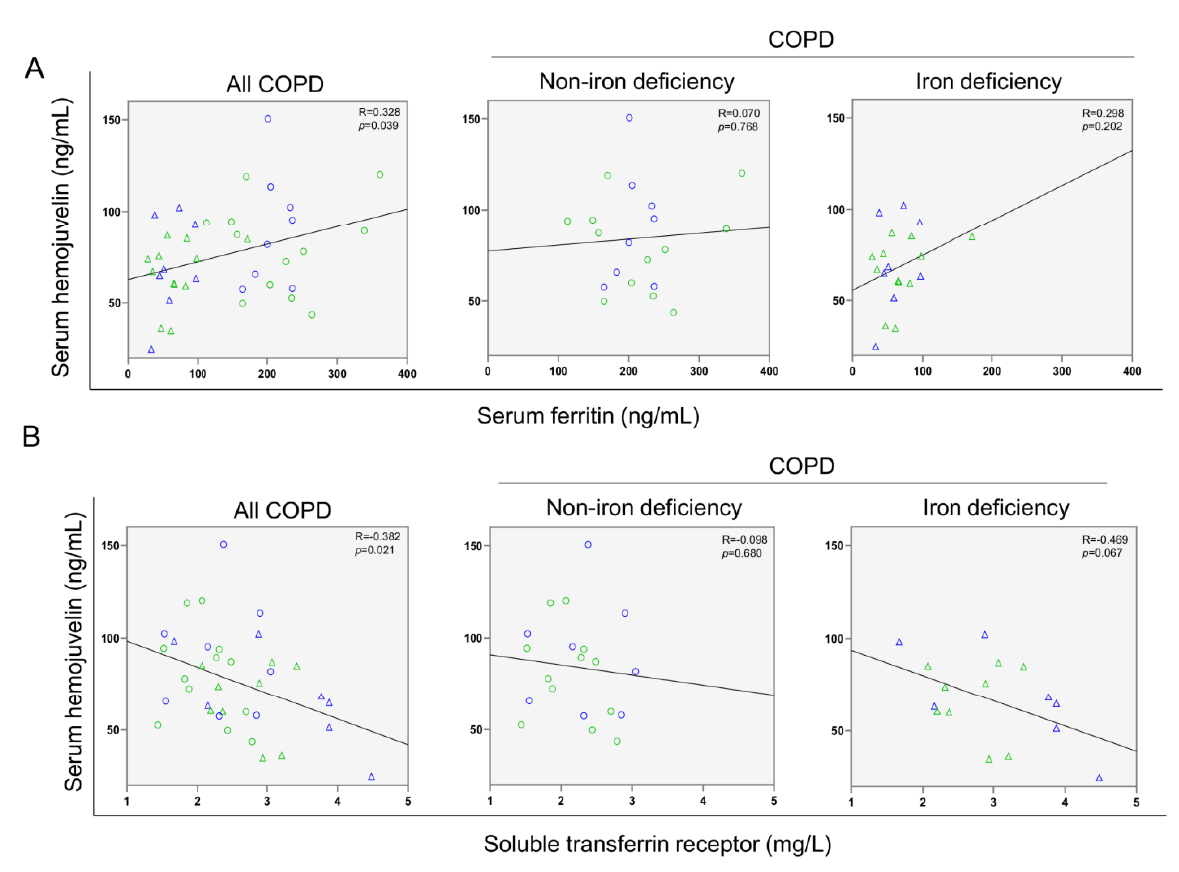
walk test (m) ( A ) and distance six-minute walk test (% predicted) ( B ) in all COPD patients ( left panels), non-iron deficiency ( middle panels) and iron deficiency ( right panels) COPD patients. In the scatter plots, the green color dots or triangles indicate male patients in either study group, while the blue color dots or triangles indicate female patients in the same groups. Definition of abbreviations: COPD, chronic obstructive pulmonary disease.